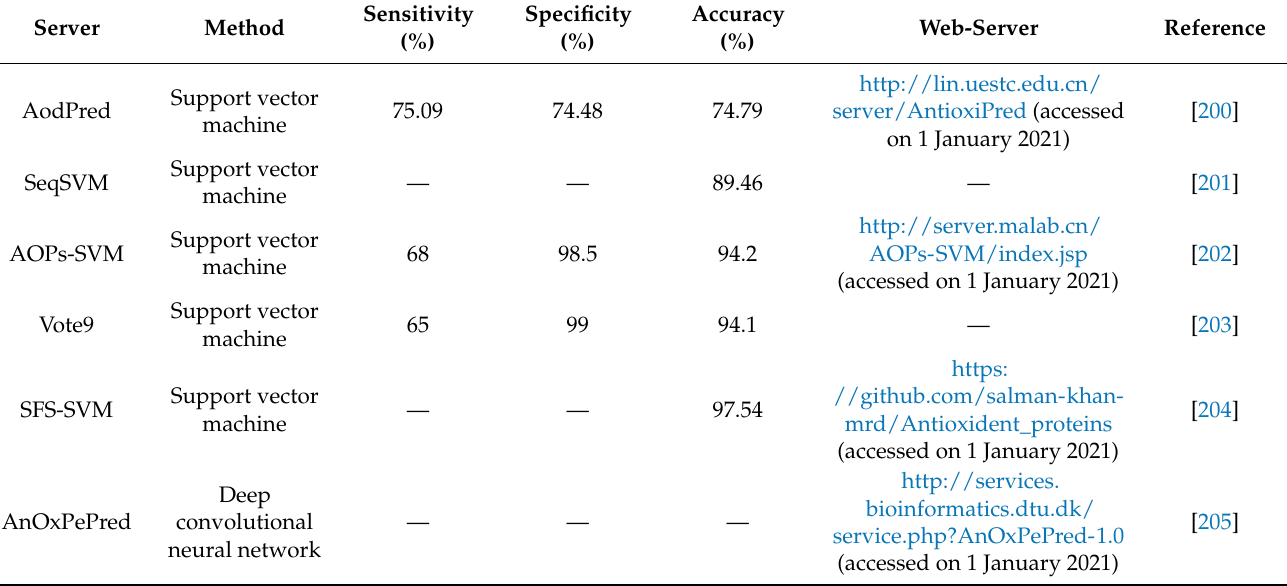
Table 4. Machine learning-based computational methods for prediction of antioxidant potential of